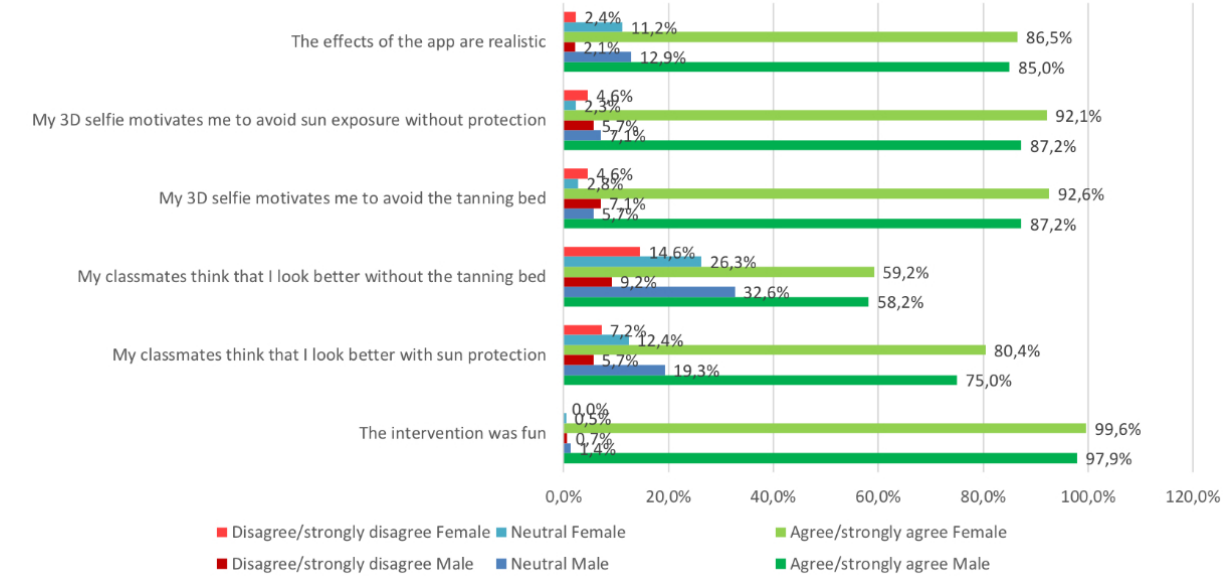
Figure 9. Results in male versus female participants. 3D: 3-dimensional.